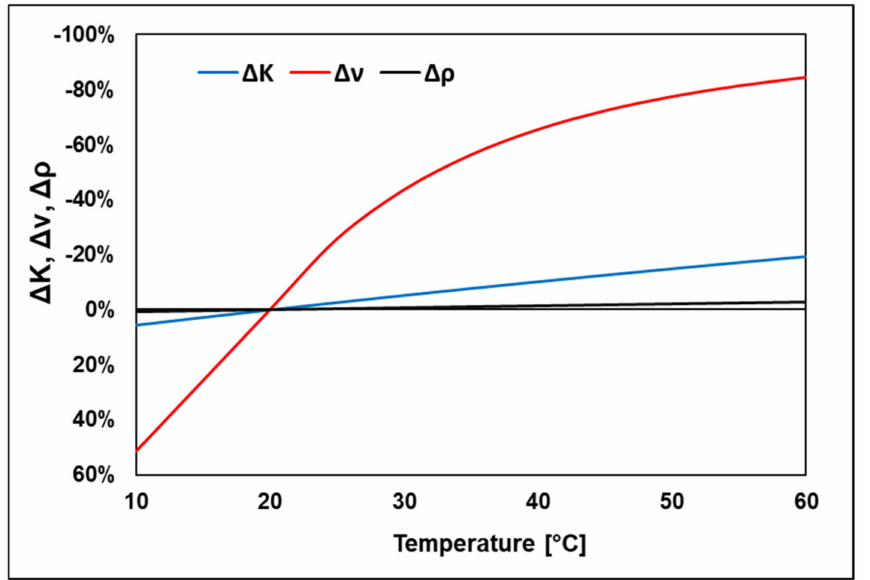
Figure 10. Influence of fluid (mineral oil) temperature on its properties: ∆ K-bulk modulus change; ∆ ν -kinematic viscosity change; ∆ ρ -density change (reference values measured at normal